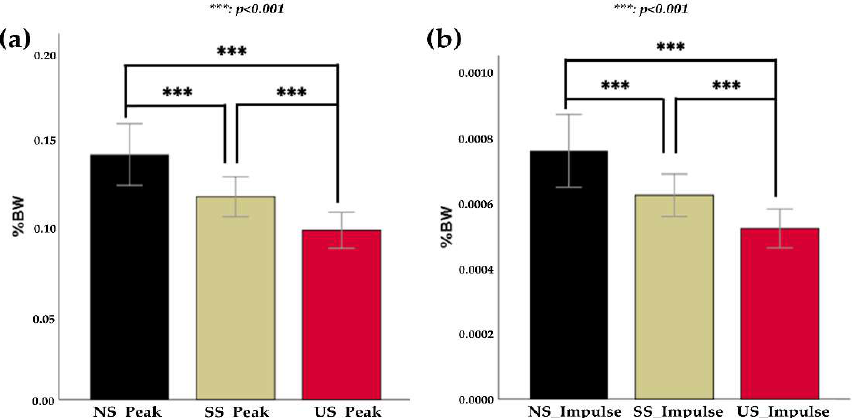
Figure 4. Comparison of peak and impulse values between socks. ( a ) Peak values (mean ± std) measured with three different socks (NS: normal socks, SS: silicone socks, and US: urethane socks) ( b ) Impulse values (mean ± std) measured with three different socks. * significant level: *** p < 0.001. There were no significant differences between socks for peak values (F (2,108 = 2.5, p = 0.087), slip time values (F (2,108) = 2.2, p = 0.116), and impulse values (F (1.7,108) = 2.1, p = 0.132) computed from the GRF data. The correlation coefficient (r) values were summa-